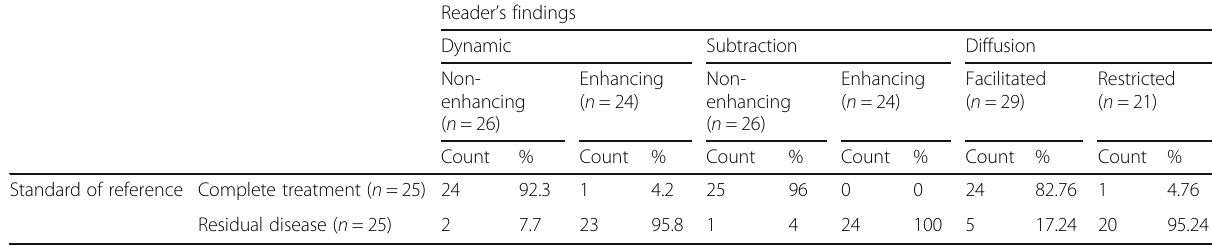
Table 3 Correlation of dynamic, subtraction, and diffusion findings obtained by reader 2 to standard of